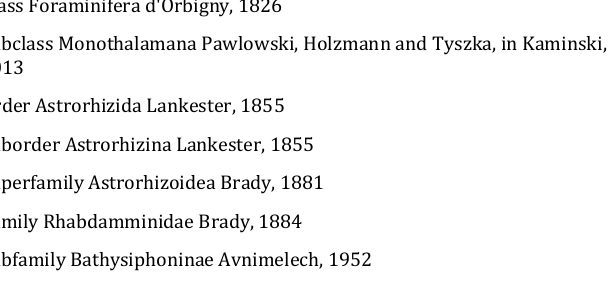
Fig. 1. Bathysiphon saidi 20, 2. Orbulinelloides agglutinatus (Saidova, 1970) x 85, 3. O. arabicus Anan, 2003 x 55, 4. O. fusca (Schultze, 1875) x 35, 5. O. kaminskii Anan, n. sp. x 4o, 6. O. sztrakosae Anan, 2021 x 35, 7. O. testacea (Flint, 1899) x 70. 8 (Anan, 1994). Repmanina mazeni Anan x 50, 9. Miliammina kenawyi Anan x 75, 10. Agglutinella reinemundi (Haque) x 90, 11. A. sori (Haque) x 60 , 12. Dentostomina ammobicarinata (Haque) x30 , 13. D. ammoirregularis (Haque) x 35 , 14. D. gapperi (Haque) x 55 , 15. Ammomassilina misrensis Anan x 30, 16. Psammolingulina bahri Anan x